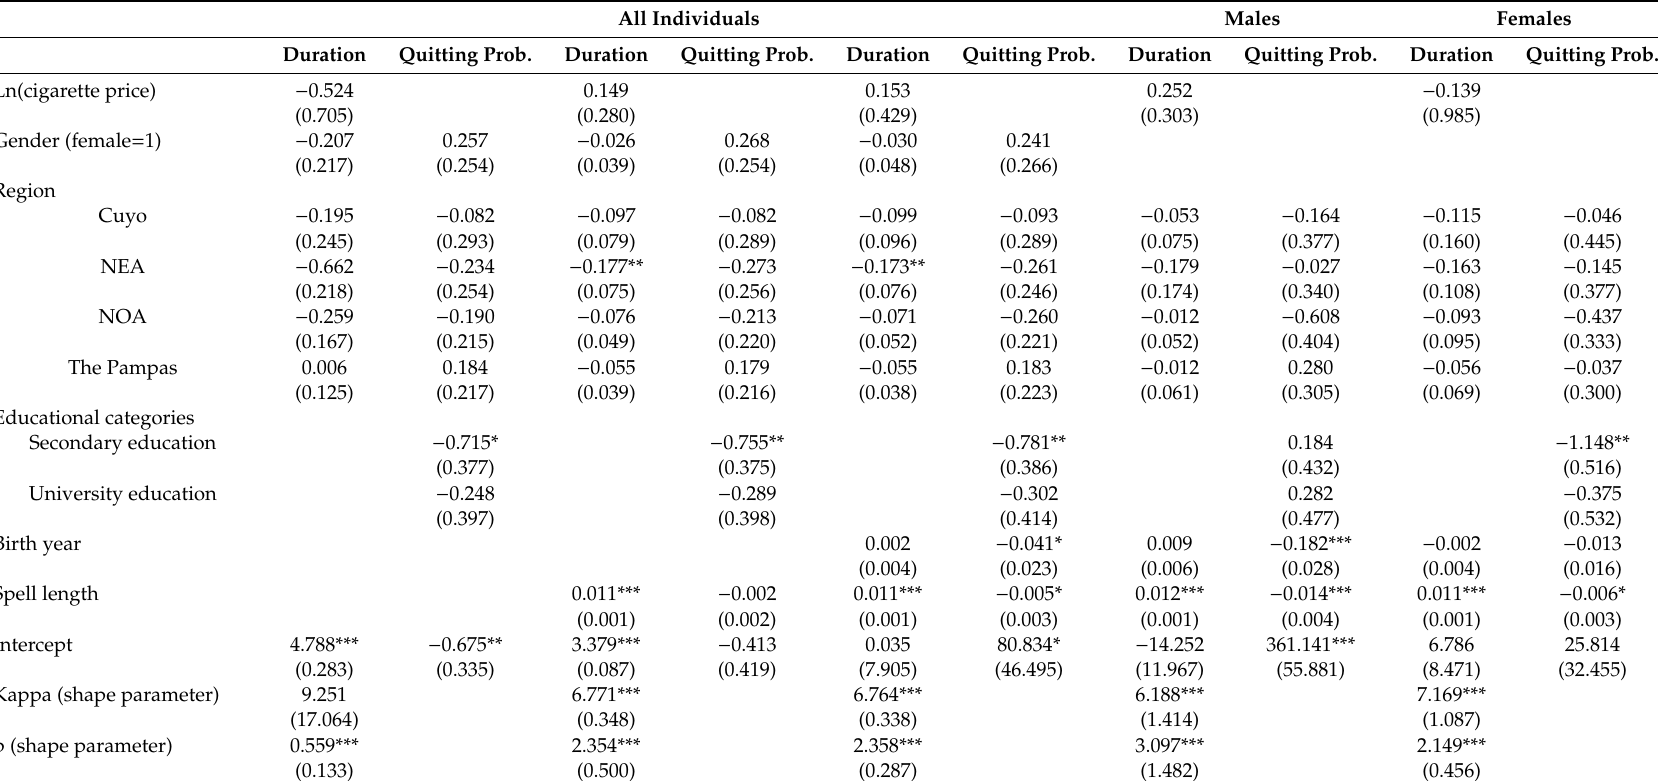
Table 2. Split-population estimations for the duration of the